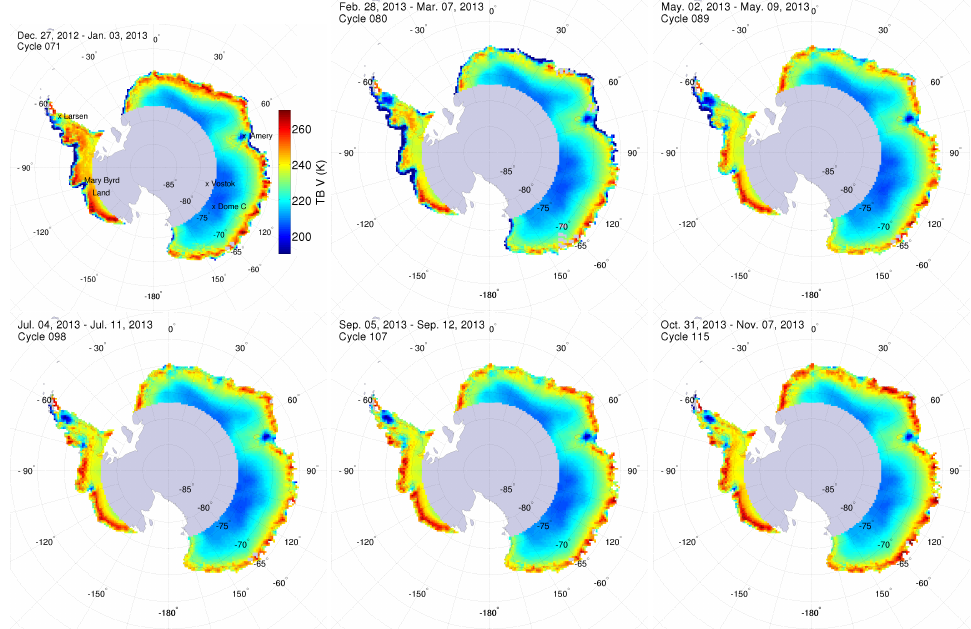
Fig. 5. Maps of TB (radiometer 3) at V polarization (in K) over the AIS every two months in 2013. Grid cells with land fraction less than 0.25 were masked.